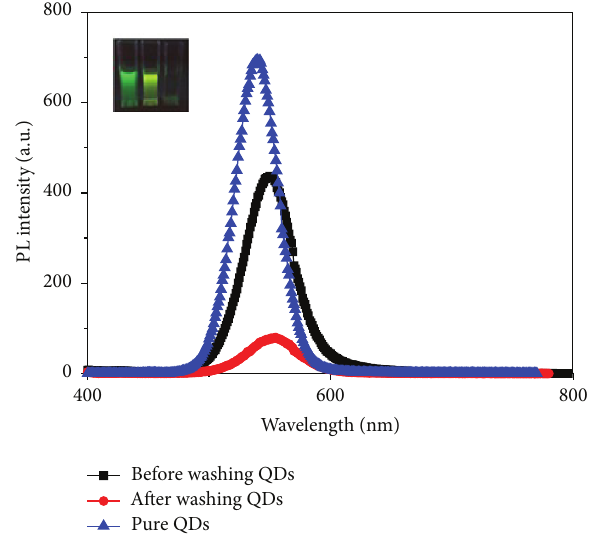
Figure 1: Fluorescence spectra of pure uncoated QDs, silica coated before washing QDs, and silica coated after washing